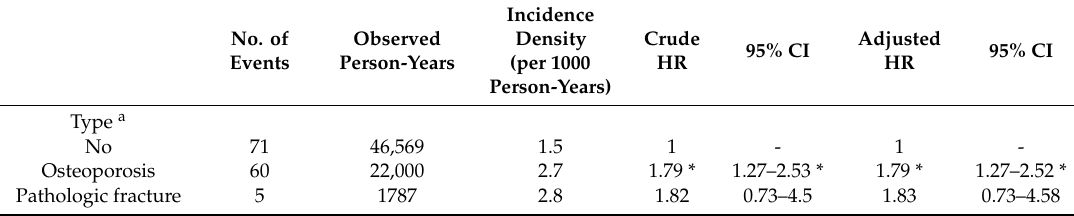
Table 4. Cox proportional hazard model of participants with stress urinary